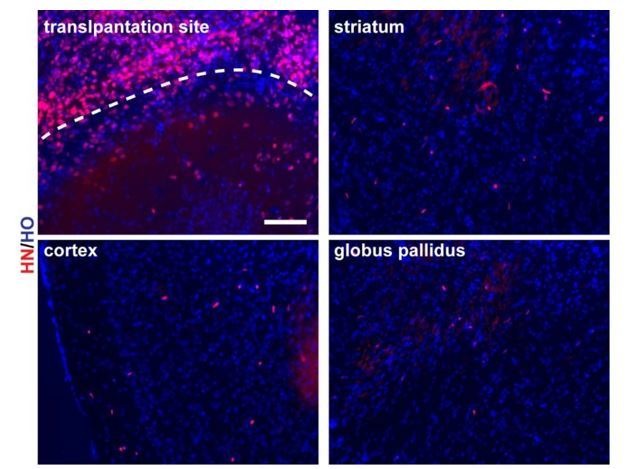
3 months mouse brain slices (scale bar, 100μm).